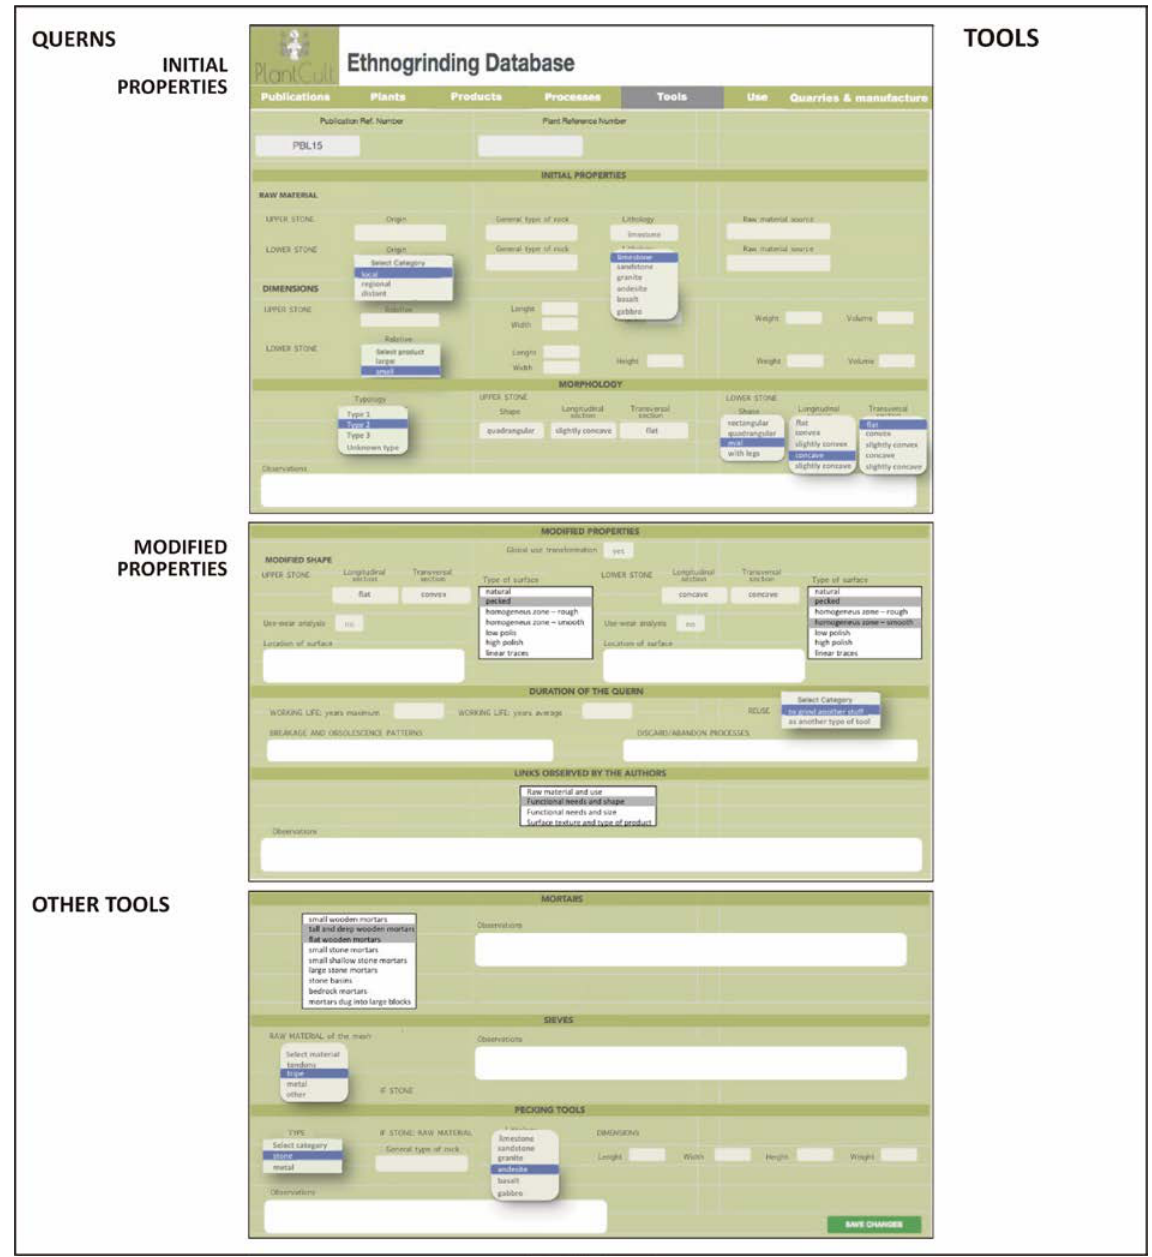
Figure 7. The Tools